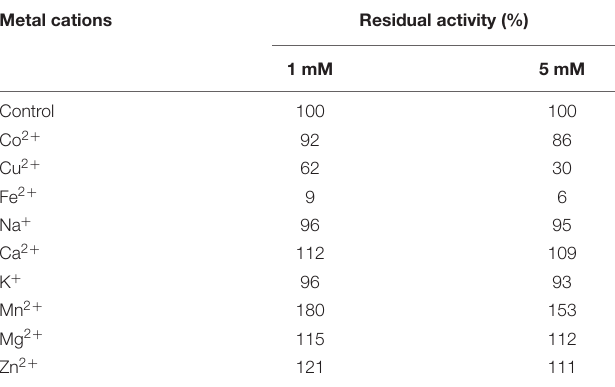
TABLE 2 | Effects of different metal cations on CsnBm